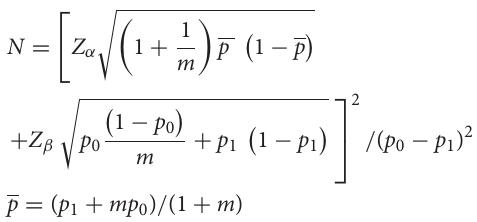
• they were not treated (i.e., a subject who refused treatment after TB diagnosis) ( Figure 1